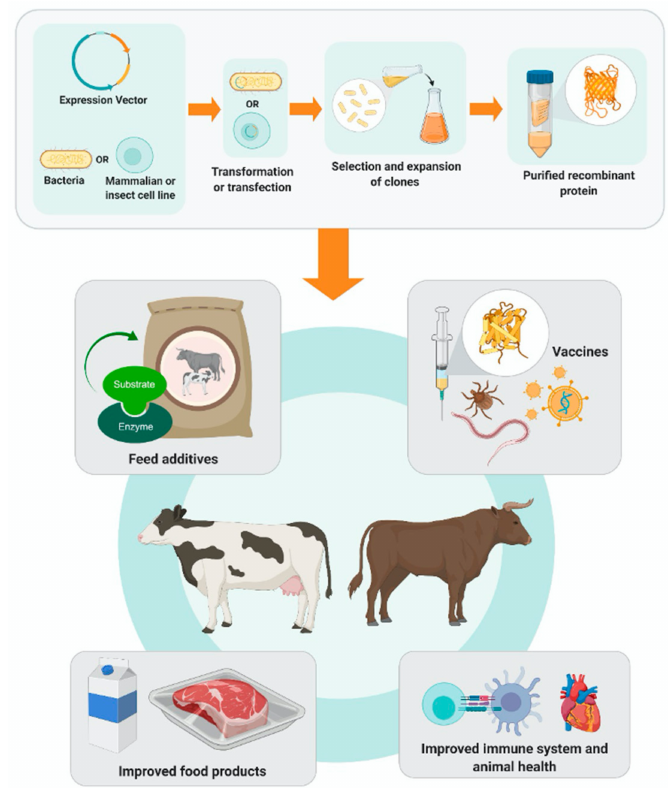
Figure 1. Summary of recombinant technologies applied to ruminant production